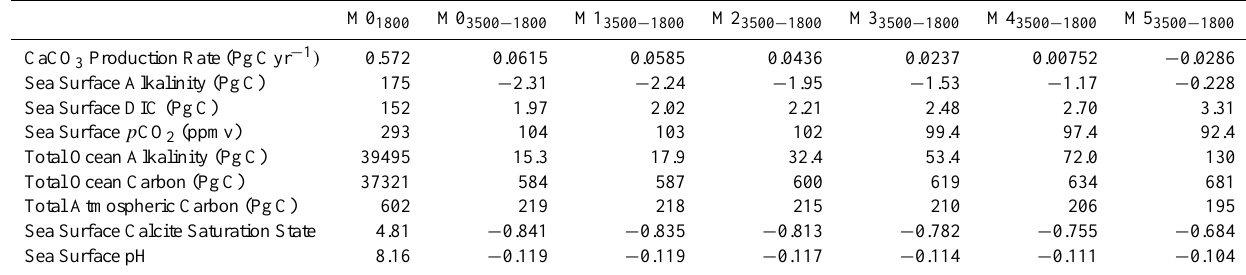
Table 3. Summary of the change in atmospheric and ocean output for years 1800–3500 for Suite M simulations. Values in column M0 1800 represent absolute output in the base model in year 1800. Subsequent columns show differences from 1800 to 3500 for each calcification sensitivity (M1 to